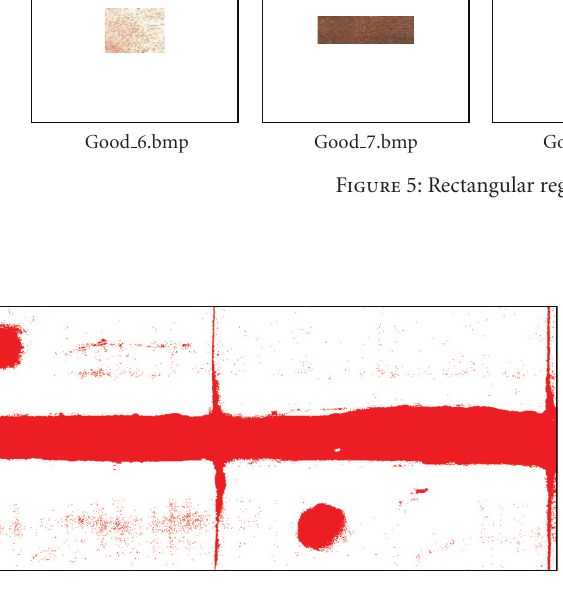
Figure 6: HSB-SVM Pixel